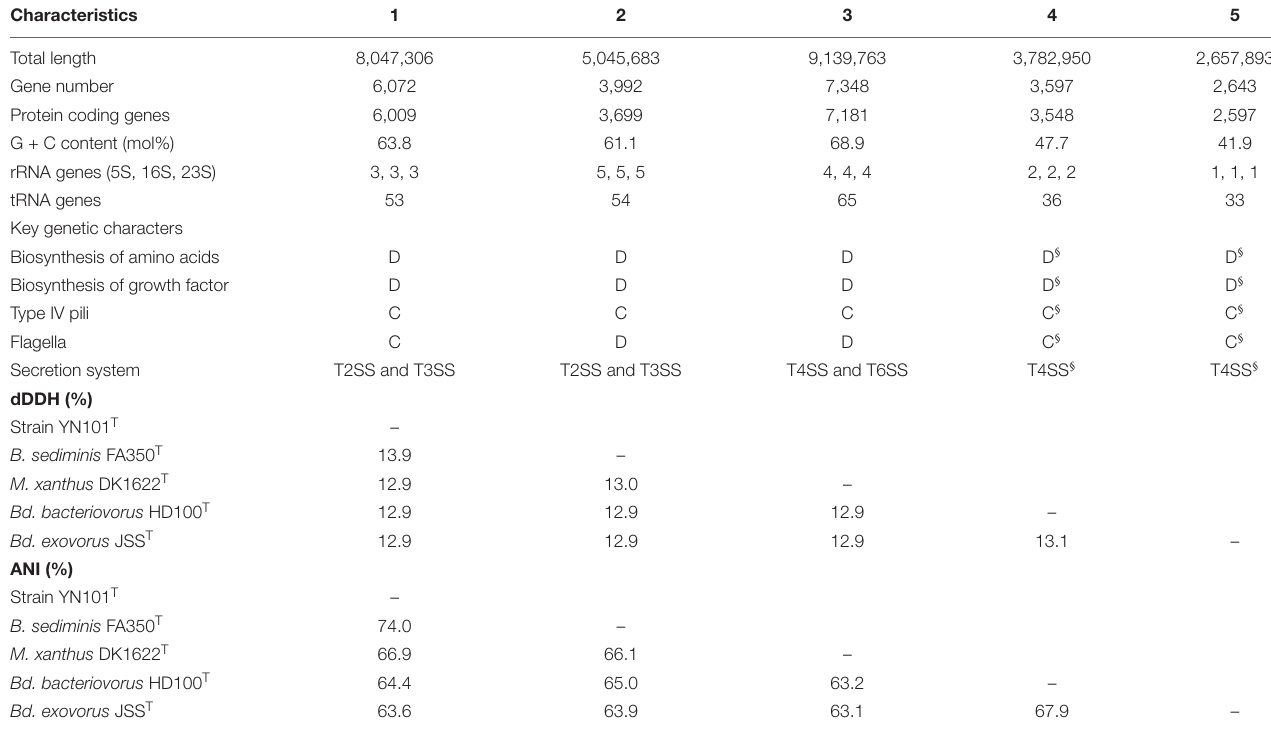
TABLE 4 | Genetic distinction between strain YN101 T and each type species of related genera. Characteristics